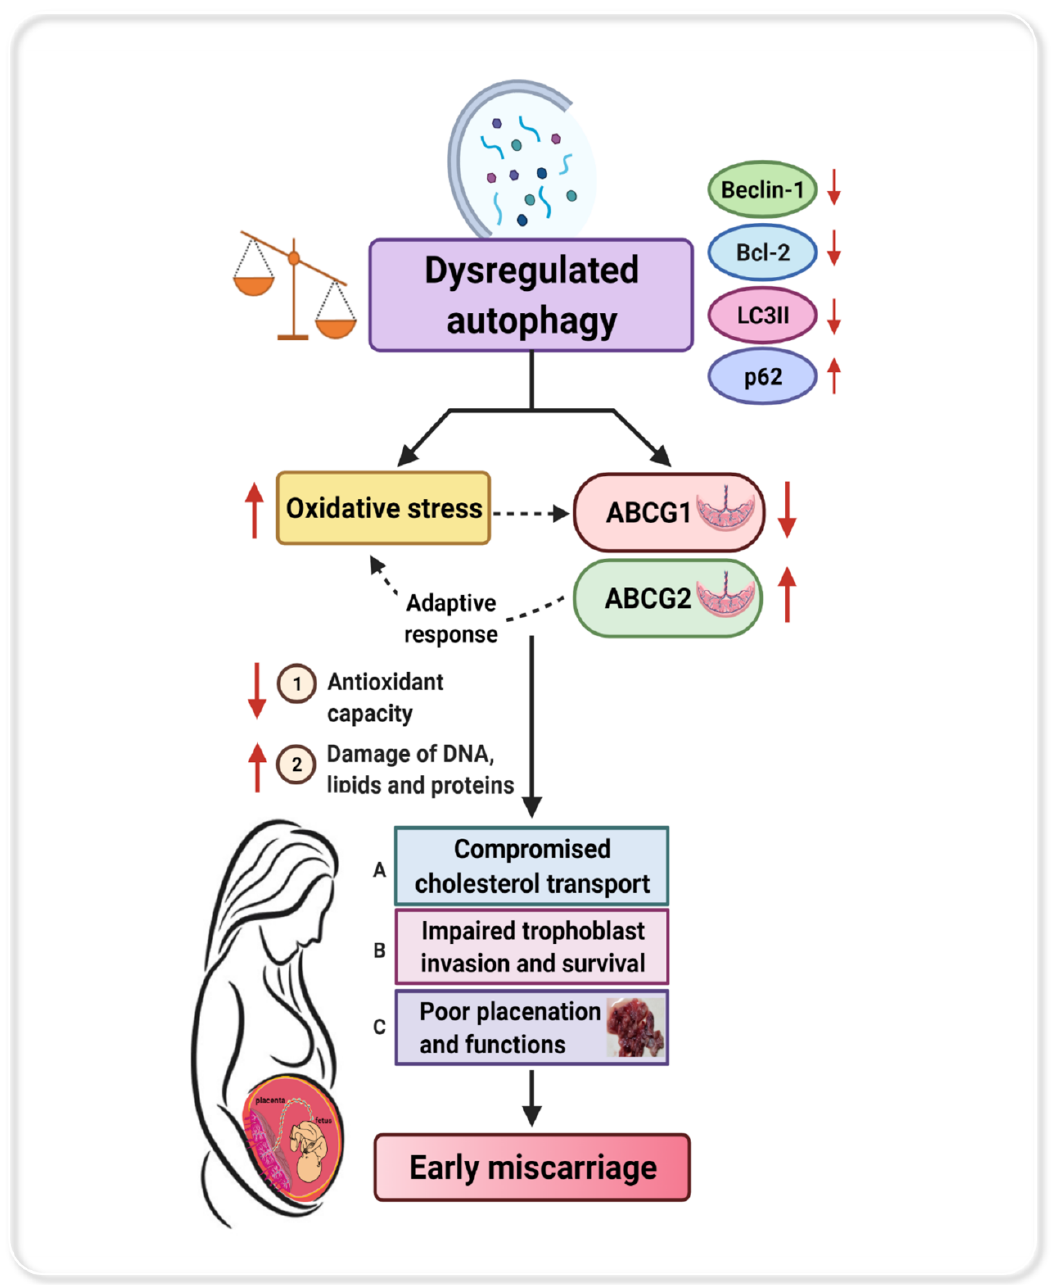
Figure 10. Schematic representation and proposed working model summarizing the results in EMC patients. Our find- ings suggest that a decreased autophagy status triggers Bcl-2-dependent oxidative stress in EMC patients. The decreased expression of ABCG1 is associated with dysregulated autophagy processes. The elevated ABCG2 expression represents a protective feedback mechanism under inhibited autophagic conditions. The aberrant gene expression of placental ABC transporters affects materno-fetal cholesterol transport in EMC. Impaired total antioxidant capacity and increased oxidative stress may further contribute to EMC (created with BioRender).